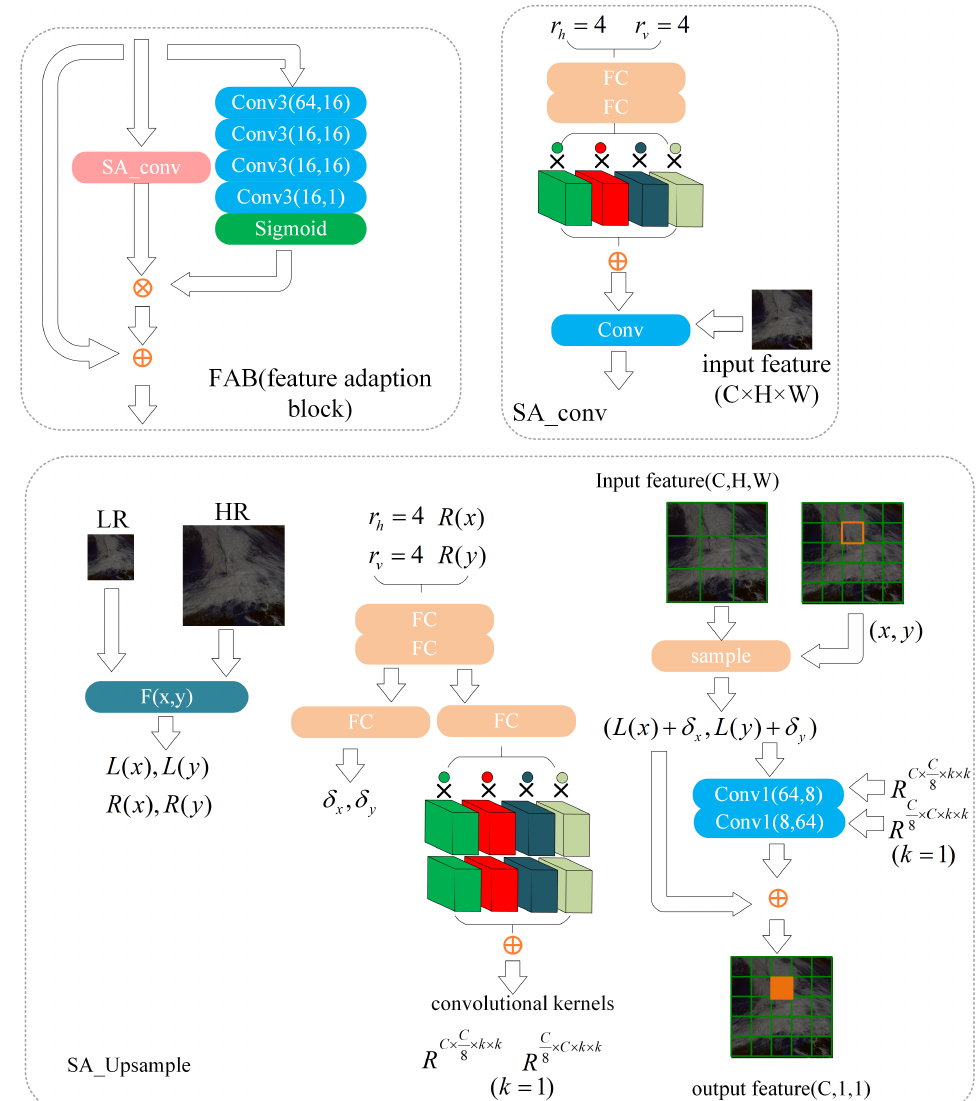
Figure 11. Blocks in